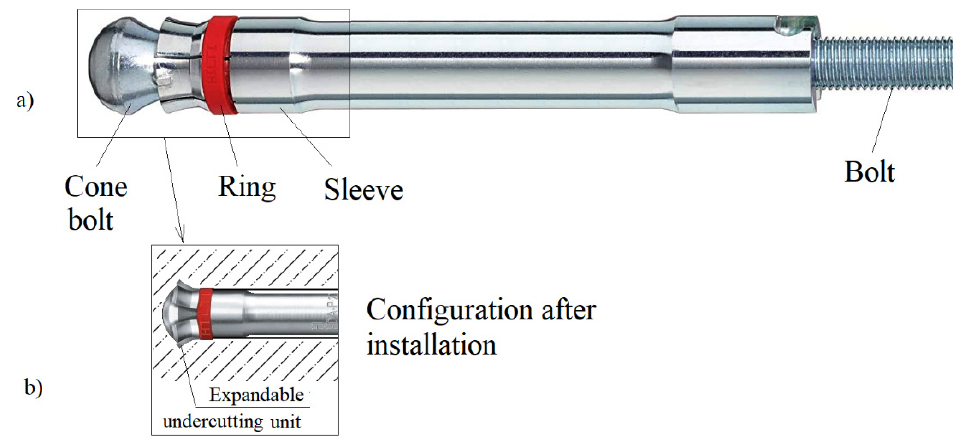
Figure 1. Undercut anchors type Hilti HAD, configuration ( a ) before installation ( b ) after installation.